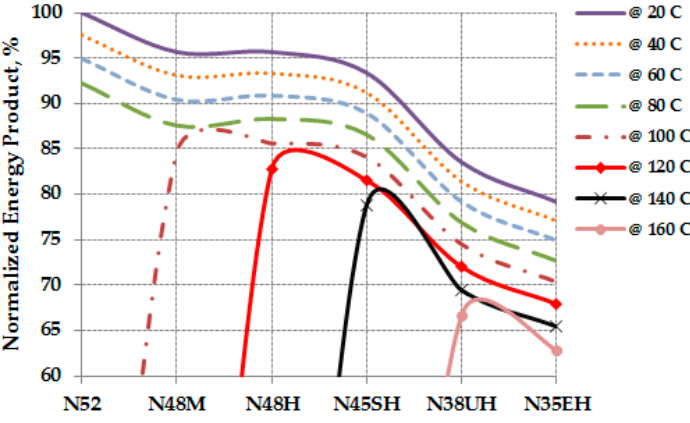
Figure 4. Degrading of the normalized energy product as a function of the temperature increase for several grades of NdFeB. Based on available information from e-magnets UK (Hertfordshire, UK) [26]. For simplification purposes, circular magnet shapes are considered to determine the magnetic flux density in the air gap between the two PM rotors. The full derivation of the sizing equation and other necessary equations for the AFPMA’s parameter determination and optimization purposes are shown in Appendix A.